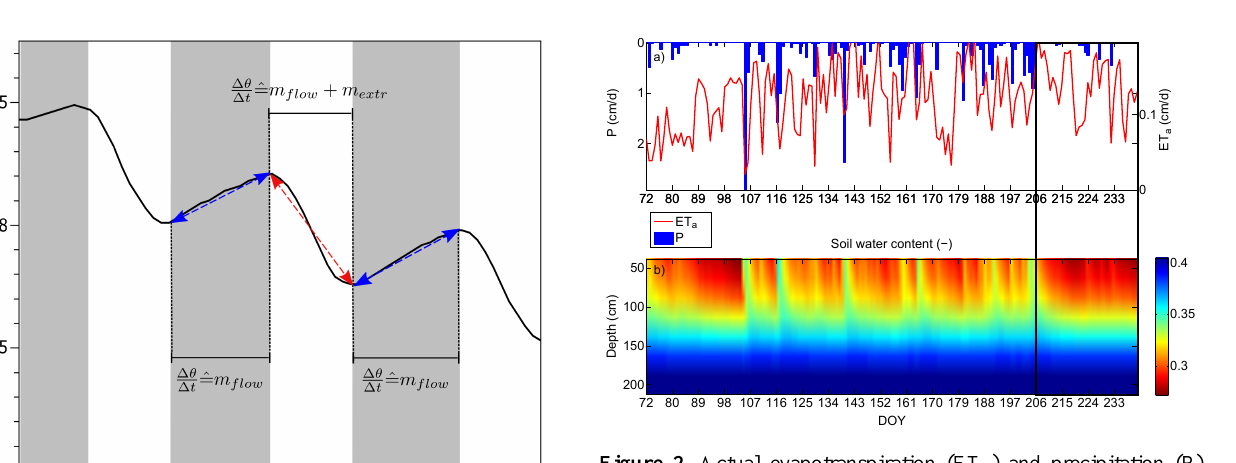
Figure 2. Actual evapotranspiration (ET a ) and precipitation (P) (cmday − 1 ) in the growing season (from March 2009 to September 2009) (a) and synthetic time series of soil water content (b) with daily